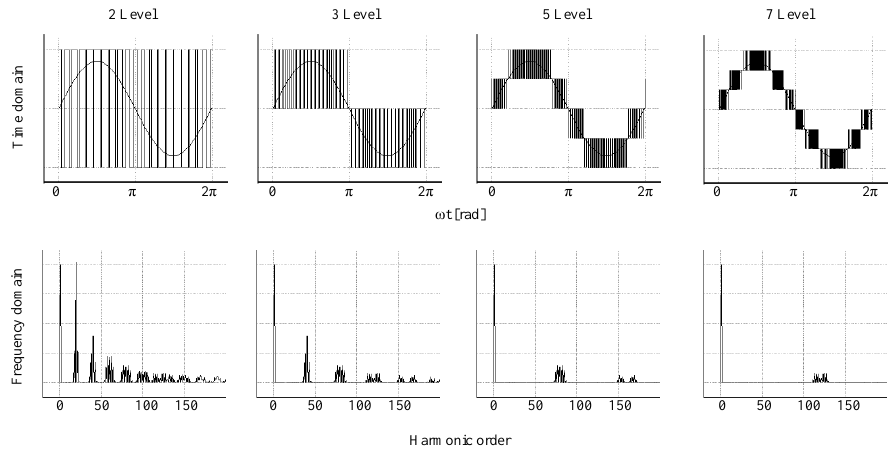
Figure 1. Influence of the voltage levels that an MLC can produce on the harmonic spectrum.